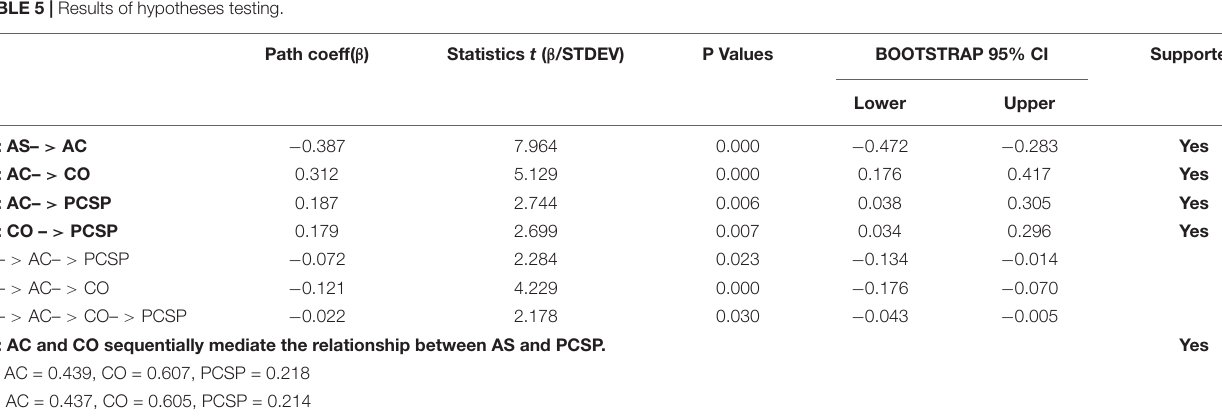
TABLE 5 | Results of hypotheses testing.